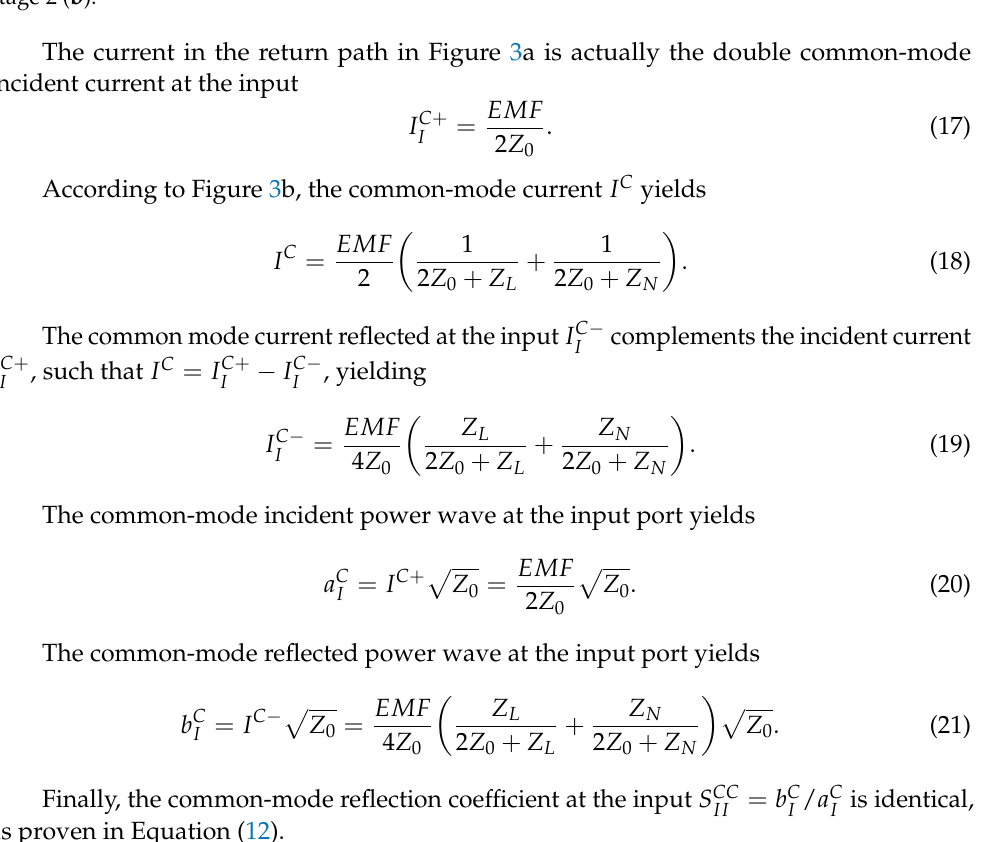
Figure 3. Explanation of the derivation of the common-mode modal matrix S CC stage 1 ( a ) and stage 2 ( b